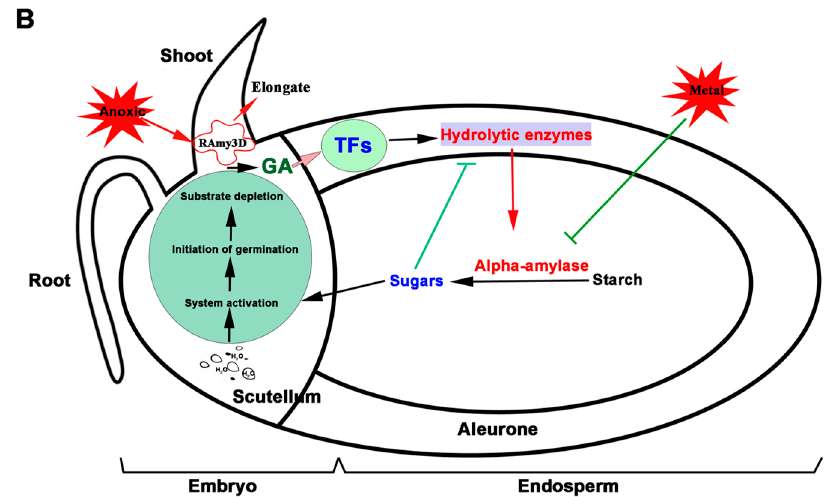
Figure 1. Rice Seed Maturation and Germination. ( A ) Changes in morphology during rice seed development [20] and germination (DAF (days after fertilization), HAI (hours after imbibition)). Rice seeds develop from the florets of the main stem which become the immature grains (the initial green color of the developing seed). The mature seed is tightly packed with starch granules (the translucent color) while imbibition rehydrates the starch granules, making them loose and thus appearing white as a result of light refection. ( B ) Events leading to rice seed germination showing the interaction and roles of different tissues during germination (Modified from Hong et al. [21]) (H 2 O (water), GA (gibberellic acid), TFs (Transcription factors)).